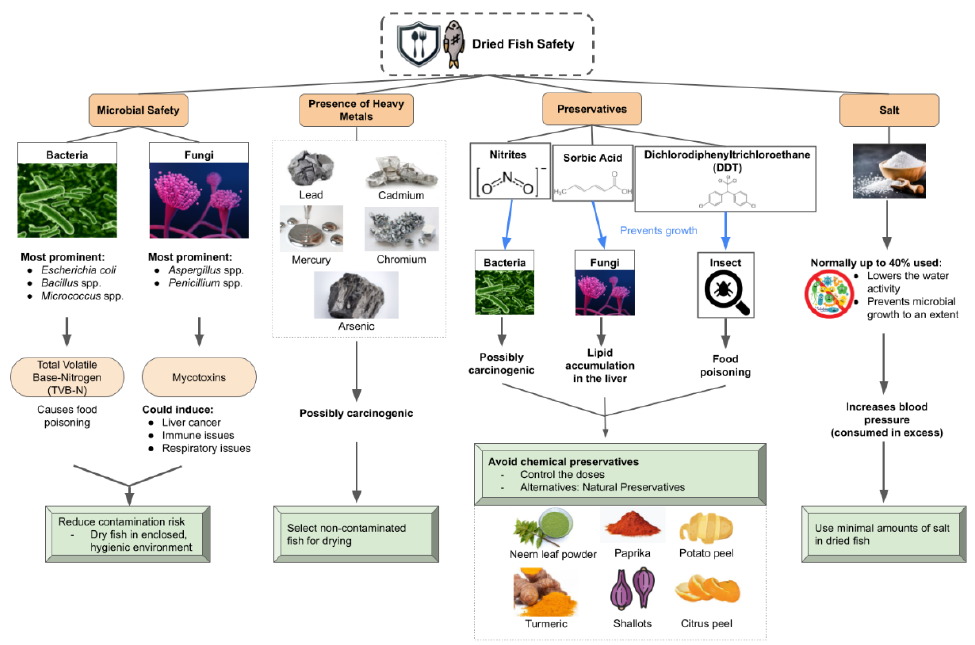
Figure 6. Significant safety aspects of dried fish along with their effects on human health and the prevention